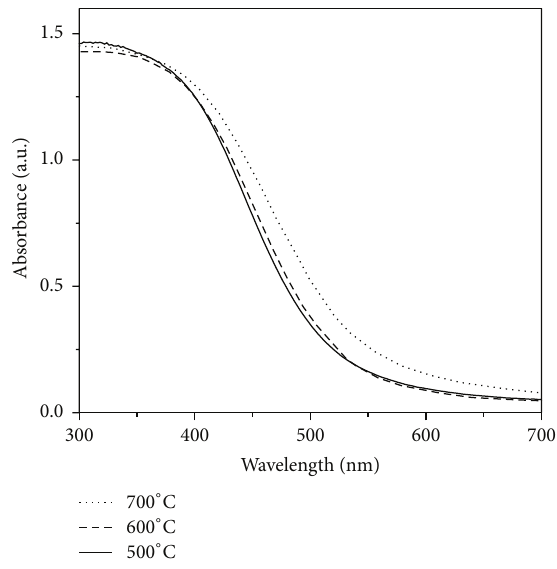
Figure 5: Diffuse reflectance UV-Vis spectra of CdIn 2 S 4 prepared at different